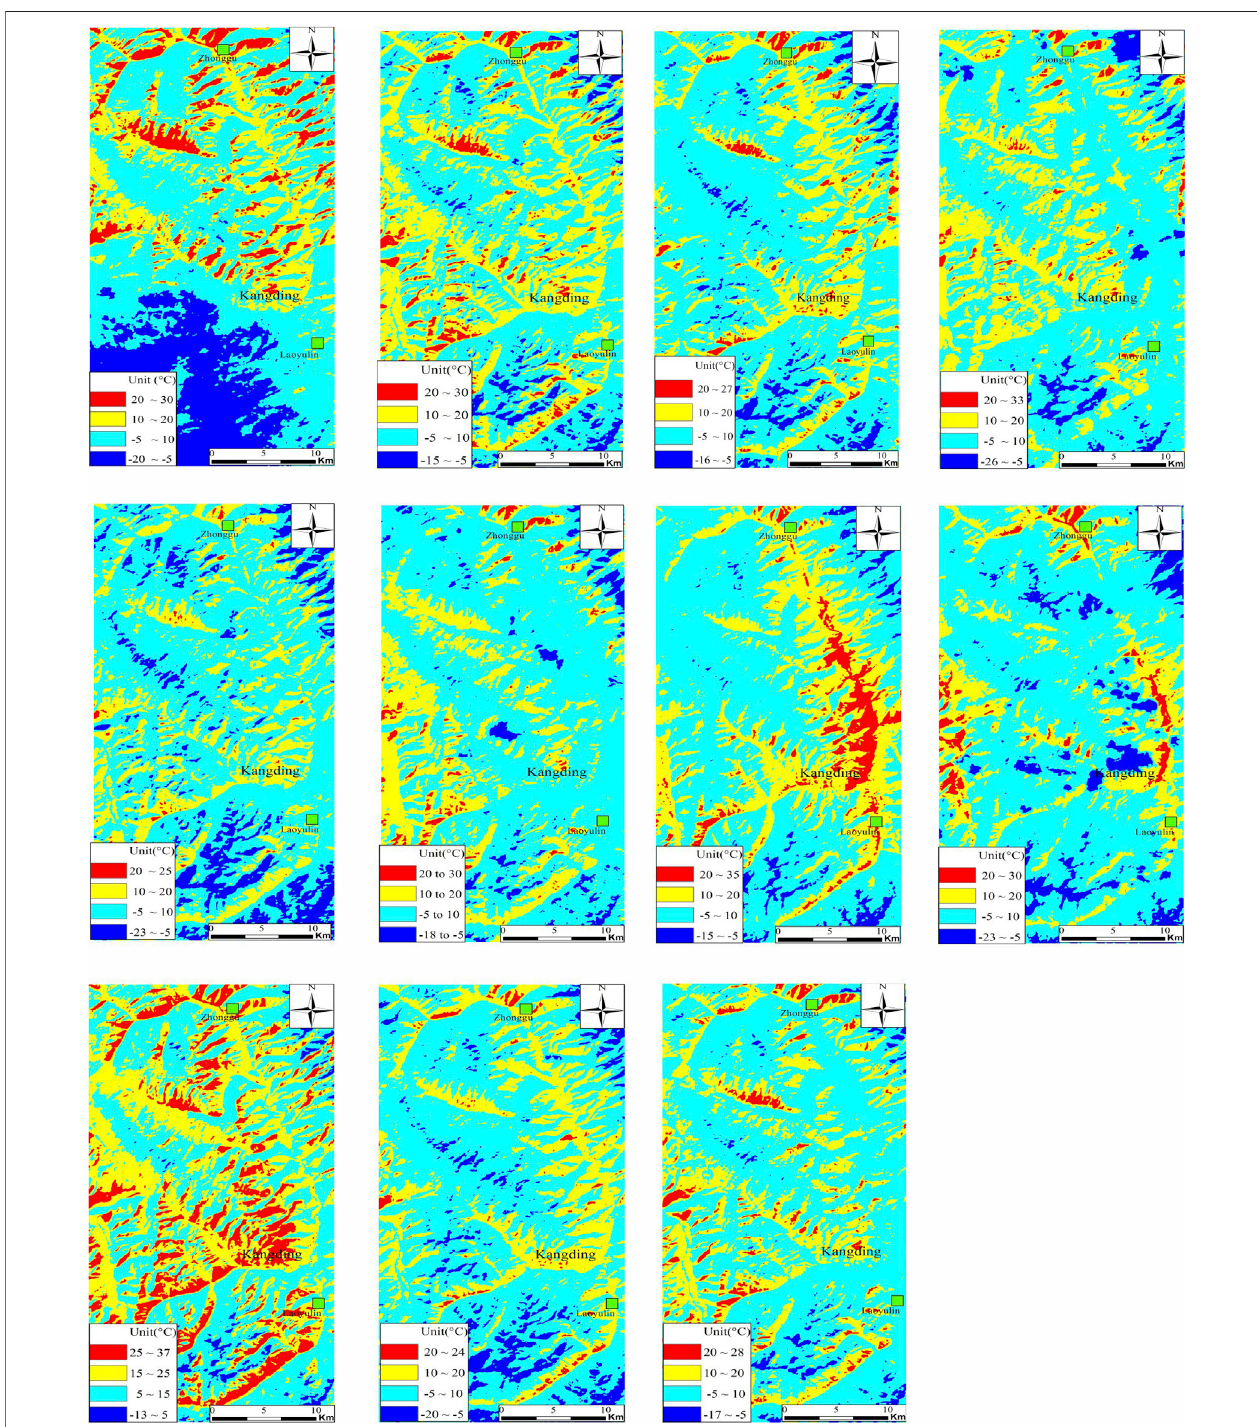
FIGURE 3 | RTE LST retrieval results. In the order of 11.04.2016 – 12.12.2017.